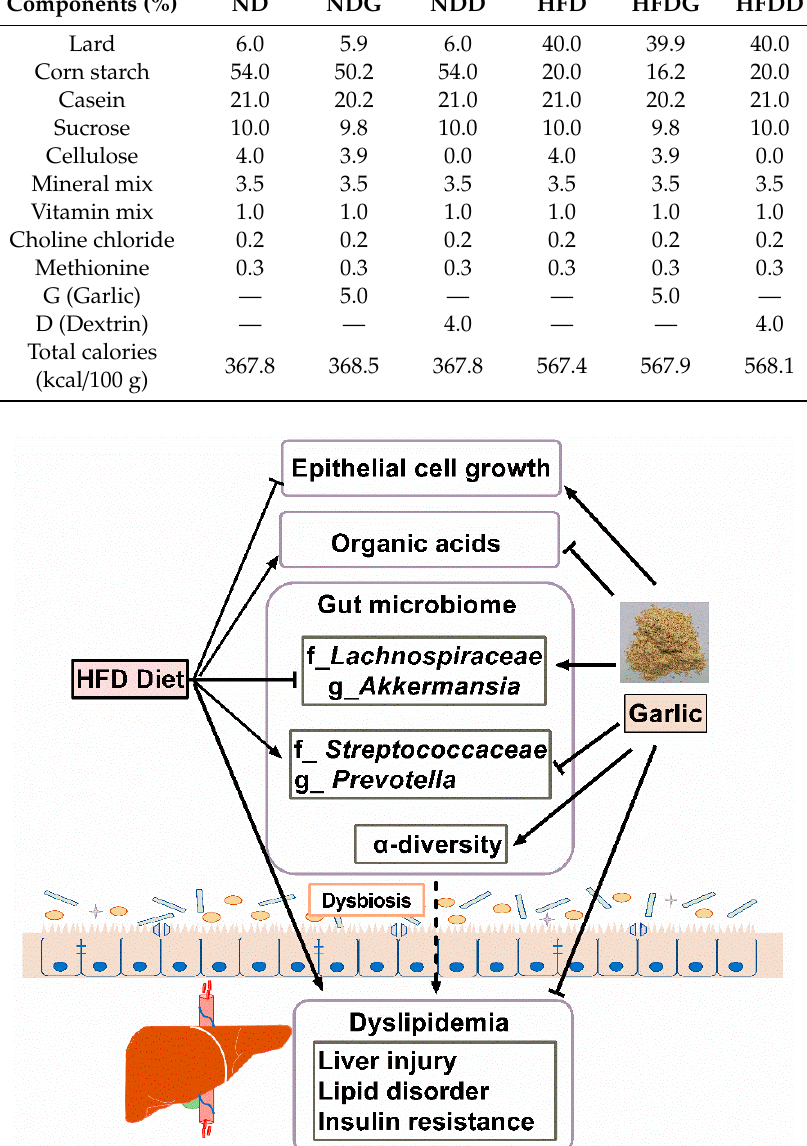
Figure A1. Graphic abstract. Whole garlic supplementation could meliorate the HFD-induced dyslipidemia and disturbance of gut microbiome.